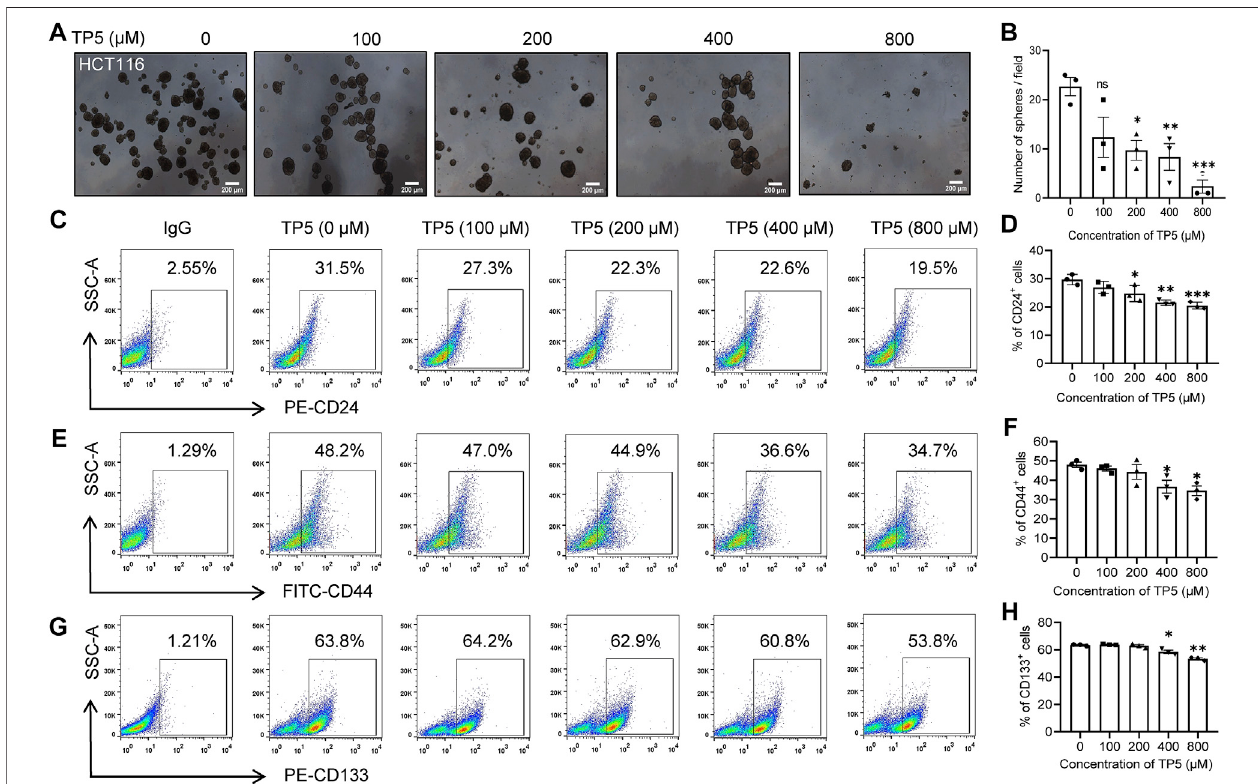
FIGURE 1 | TP5 inhibits the stemness of cancer stem cells in HCT116 cells. (A, B) Representative photomicrographs of sphere formation experiments (A) and statistical analysis of the number of spheres with diameter ≥ 140 μ m in visual fi eld (B) . HCT116 cells were incubated with different treatments of TP5 (0, 100, 200, 400, and800 μ M)andgrowninserum-freemediumfor6 days.Scalebar=200 μ m. (C – H) FlowcytometeranalysisoftheexpressionofCD24,CD44orCD133 (C,E,G) and pooled data of cell surface markers CD24 (D) , CD44 (F) and CD133 (H) ( n = 3 independent experiments). All data are expressed as mean ± SD; * p < 0.05, ** p < 0.01 and *** p < 0.001 vs. control, one-way ANOVA with Dunnett ’ s post-hoc test, (A) , [F (4, 10) = 8.265, p = 0.0033], (B) , [F (4, 10) = 11.76, p = 0.0008] [F (4, 10) = 5.039 p = 0.0174], [F (4, 10) = 34.00, p <